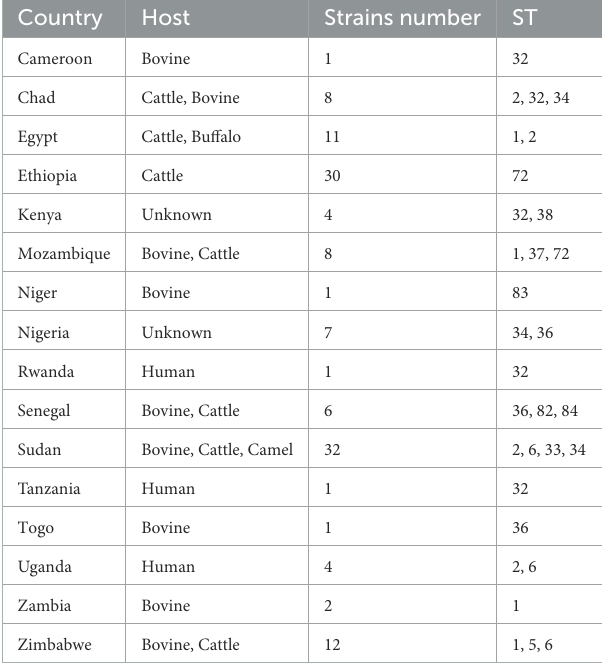
TABLE 1 Country, hosts, number of strains and sequencing type (ST) of 129 Brucella abortus strains from Africa used for multi-locus sequence typing (MLST)